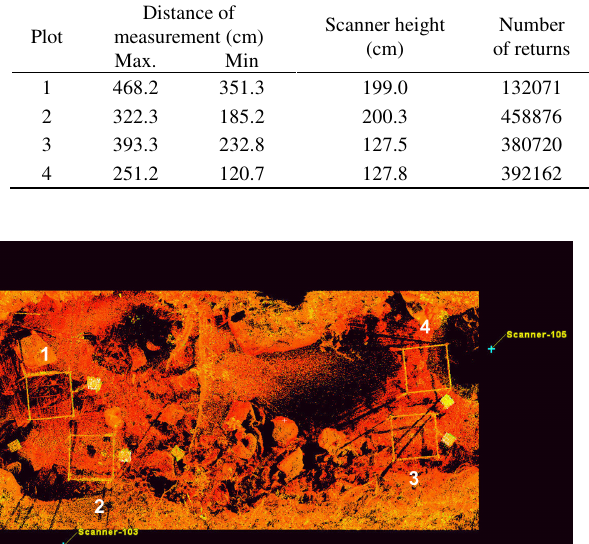
Table 1. Summary of TLS data acquisition